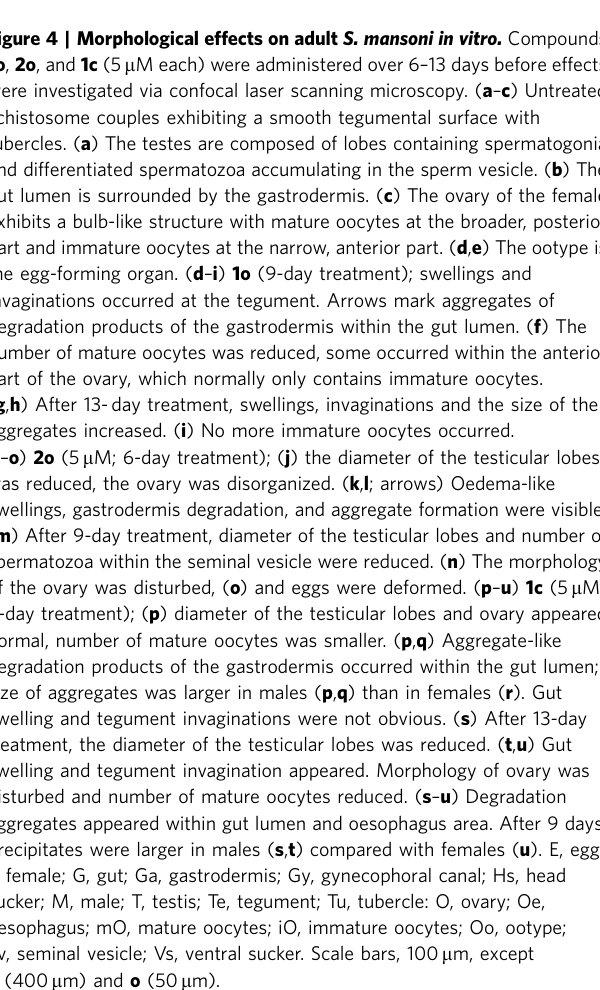
Figure 4 | Morphological effects on adult S. mansoni in vitro. Compounds 1o , 2o , and 1c (5 m M each) were administered over 6–13 days before effects were investigated via confocal laser scanning microscopy. ( a – c ) Untreated schistosome couples exhibiting a smooth tegumental surface with tubercles. ( a ) The testes are composed of lobes containing spermatogonia and differentiated spermatozoa accumulating in the sperm vesicle. ( b ) The gut lumen is surrounded by the gastrodermis. ( c ) The ovary of the female exhibits a bulb-like structure with mature oocytes at the broader, posterior part and immature oocytes at the narrow, anterior part. ( d , e ) The ootype is the egg-forming organ. ( d – i ) 1o (9-day treatment); swellings and invaginations occurred at the tegument. Arrows mark aggregates of degradation products of the gastrodermis within the gut lumen. ( f ) The number of mature oocytes was reduced, some occurred within the anterior part of the ovary, which normally only contains immature oocytes. ( g , h ) After 13-day treatment, swellings, invaginations and the size of the aggregates increased. ( i ) No more immature oocytes occurred. ( j – o ) 2o (5 m M; 6-day treatment); ( j ) the diameter of the testicular lobes was reduced, the ovary was disorganized. ( k , l ; arrows) Oedema-like swellings, gastrodermis degradation, and aggregate formation were visible. ( m ) After 9-day treatment, diameter of the testicular lobes and number of spermatozoa within the seminal vesicle were reduced. ( n ) The morphology of the ovary was disturbed, ( o ) and eggs were deformed. ( p – u ) 1c (5 m M; 9-day treatment); ( p ) diameter of the testicular lobes and ovary appeared normal, number of mature oocytes was smaller. ( p , q ) Aggregate-like